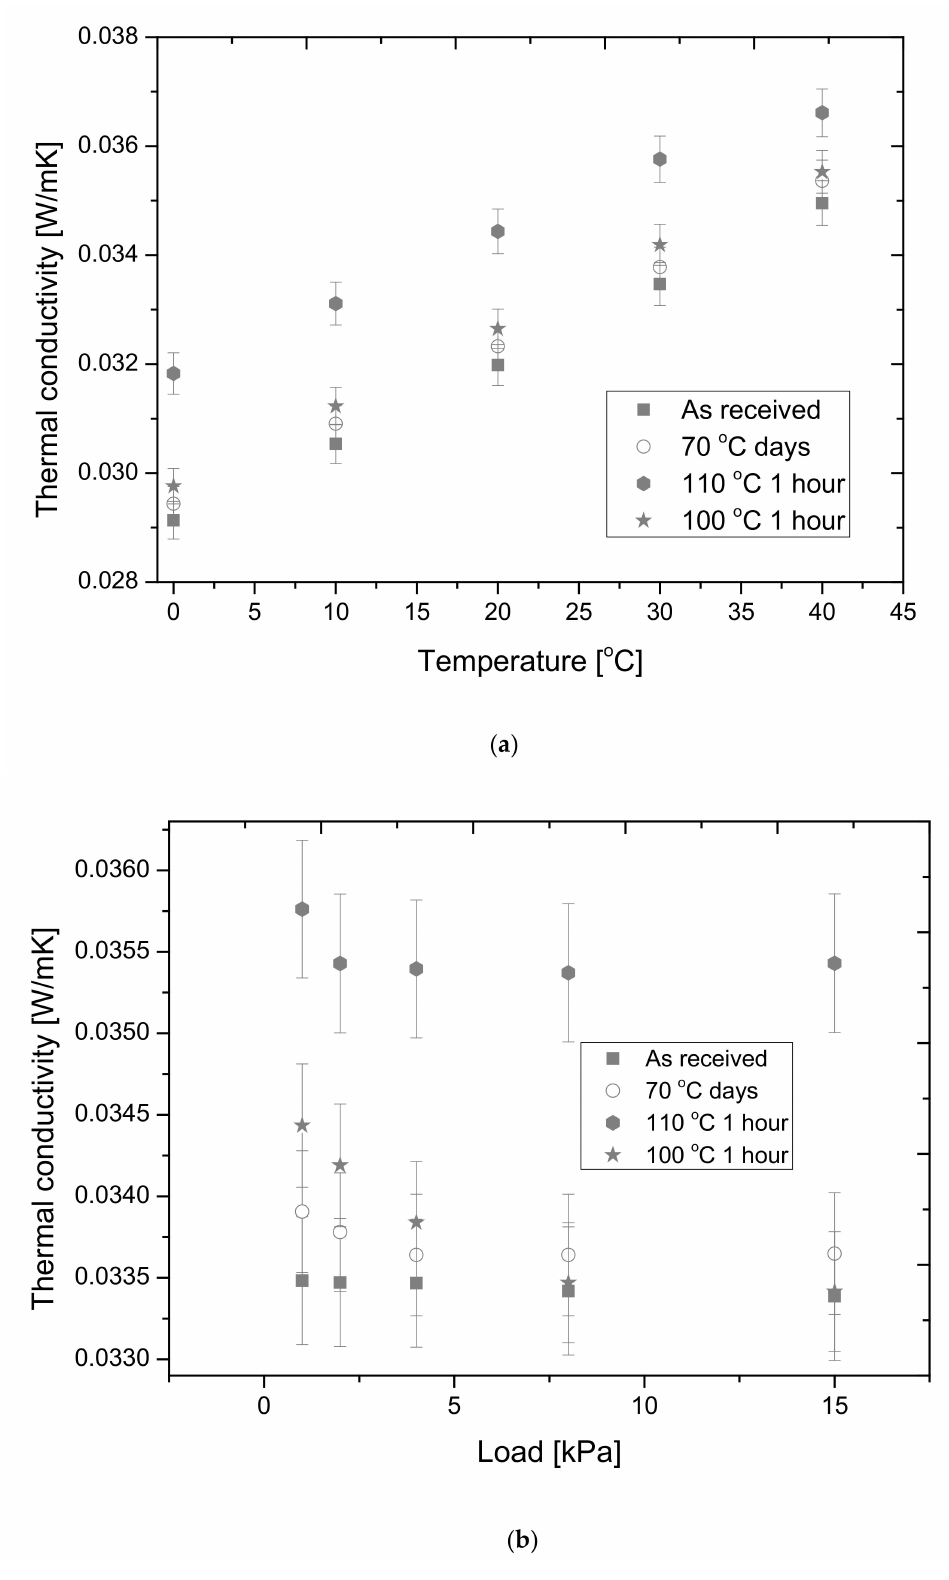
Figure 6. ( a ) Thermal conductivities of the samples in the function of the mean temperature. ( b ) The thermal conductivities in the function of the applied